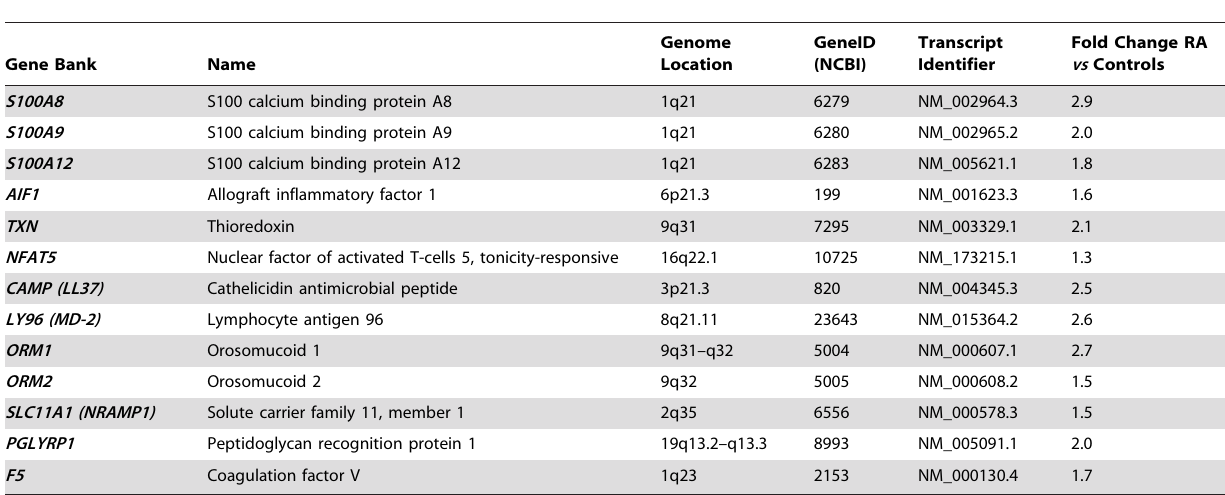
Table 2. Differentially up-regulated transcripts linked to Immunity and Defense biological process in RA patients.